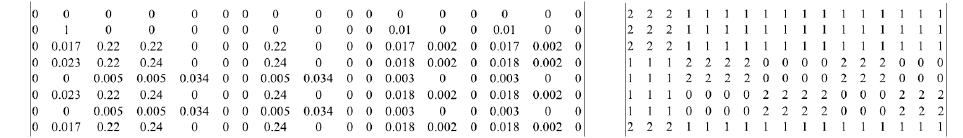
Figure A.2. The left matrix contains the symmetries scores, whereas the right matrix hosts the length of paths scores.